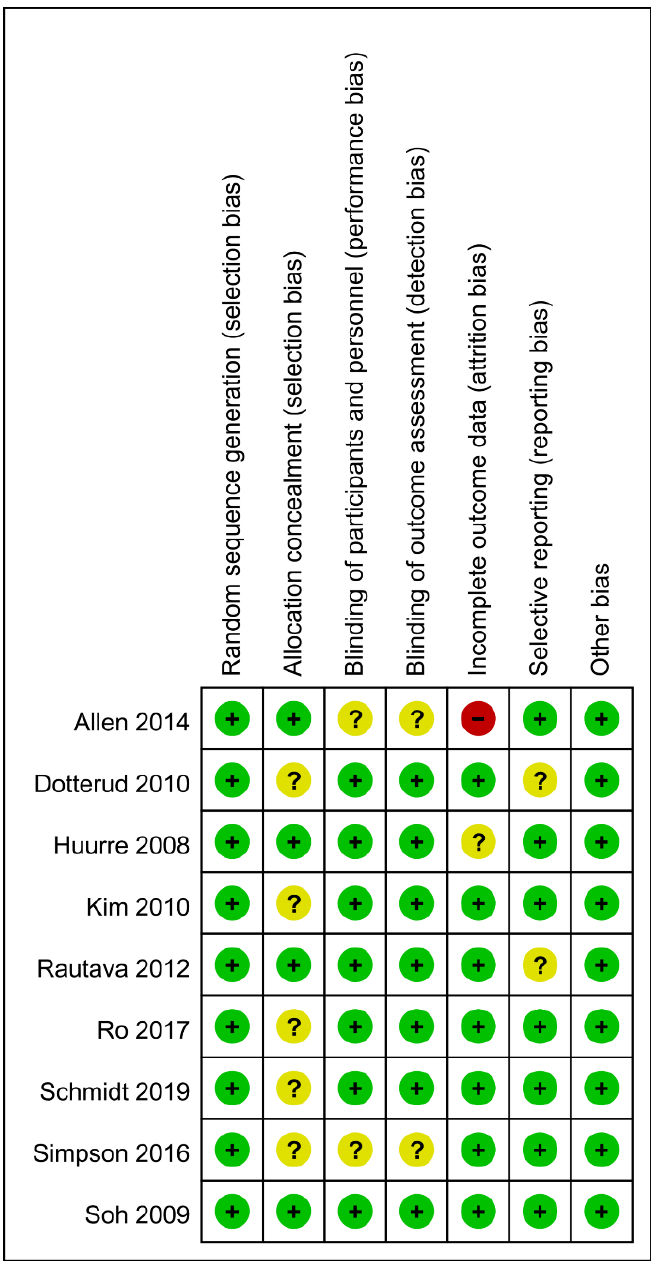
Figure 2. Risk of bias graph per type of bias assessed. “+”: low risk of bias, “-”: high risk of bias, “?”: unknown risk